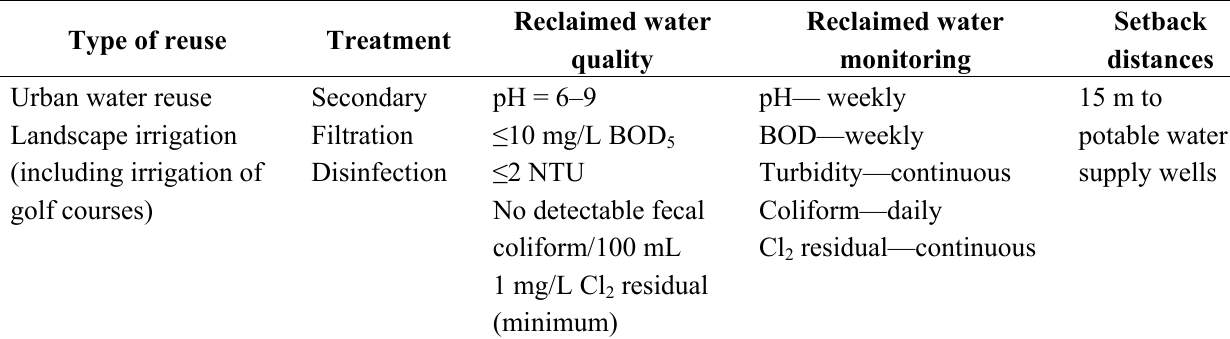
Table 8. Guidelines for irrigation of golf courses (modified from